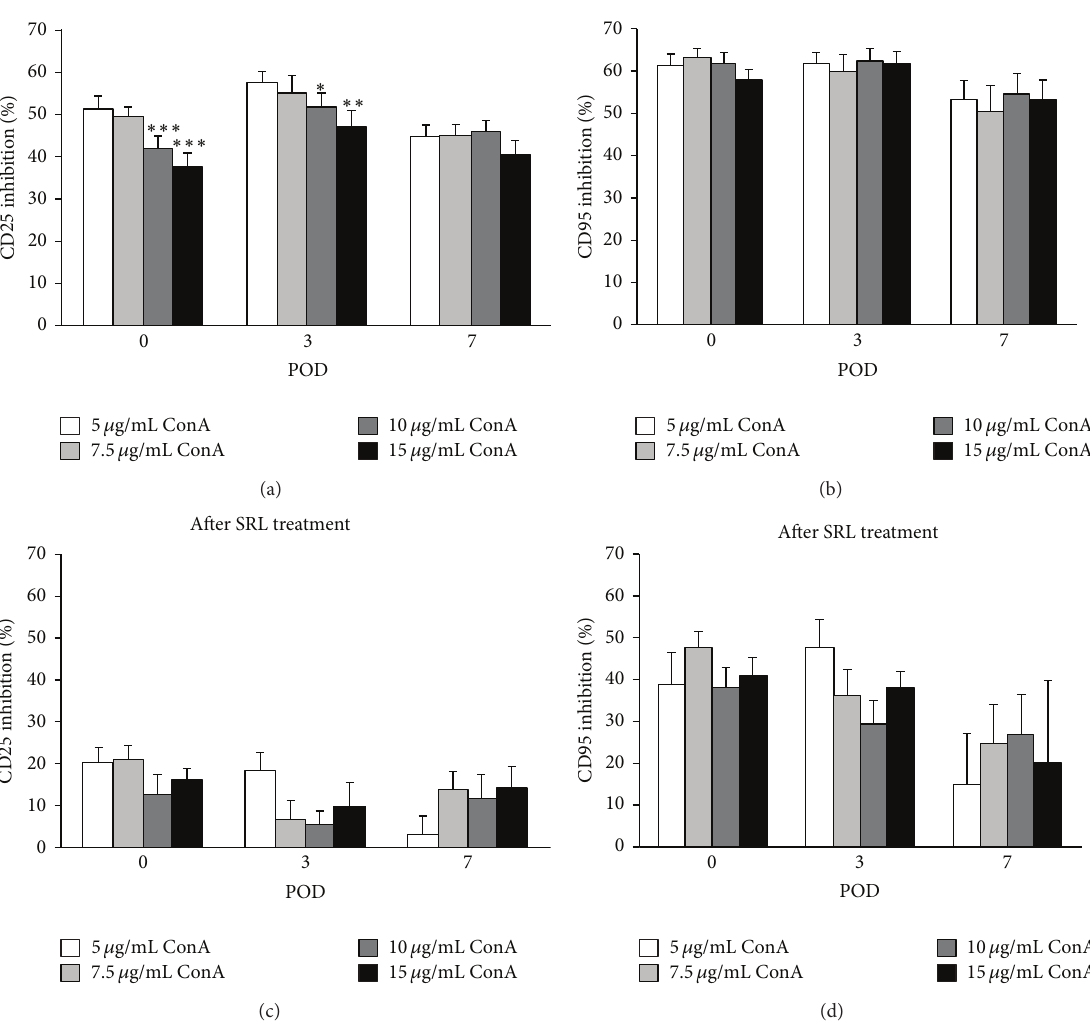
Figure 2: Inhibition of CD25 ((a), (c)) and CD95 ((b), (d)) expression after treatment with Cyclosporin A (CsA; (a), (b)) or sirolimus (SRL; (c), (d)) and stimulation with different concentrations of ConA preoperatively (POD-0) and on postoperative days (POD)-3 and -7. Data are represented as mean ± S.E.M. Statistics: Mann-Whitney versus ConA 5 𝜇 g/mL; ∗ 𝑃 < 0.05 ; ∗∗ 𝑃 < 0.02 ; ∗∗∗ 𝑃 < 0.01